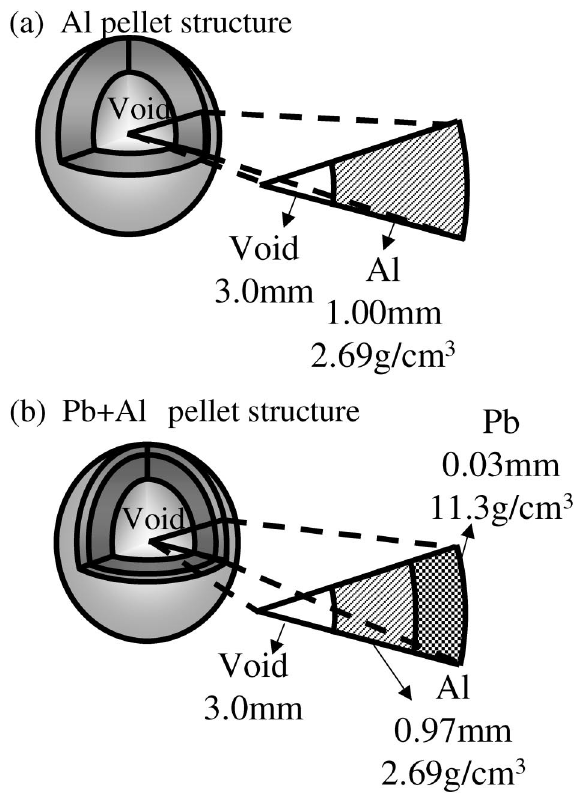
FIG. 1. Fuel target structure. (a) The Al layer thickness and mass density are 1.00 mm and 2 : 69 g = cm 3 . (b) The Pb layer thickness and mass density are 0.03 mm, 11 : 3 g = cm 3 and Al are 0.97 mm, 2 : 69 g = cm 3 , respectively. The initial target tem- perature varies from 1 to 400 eV in this study.